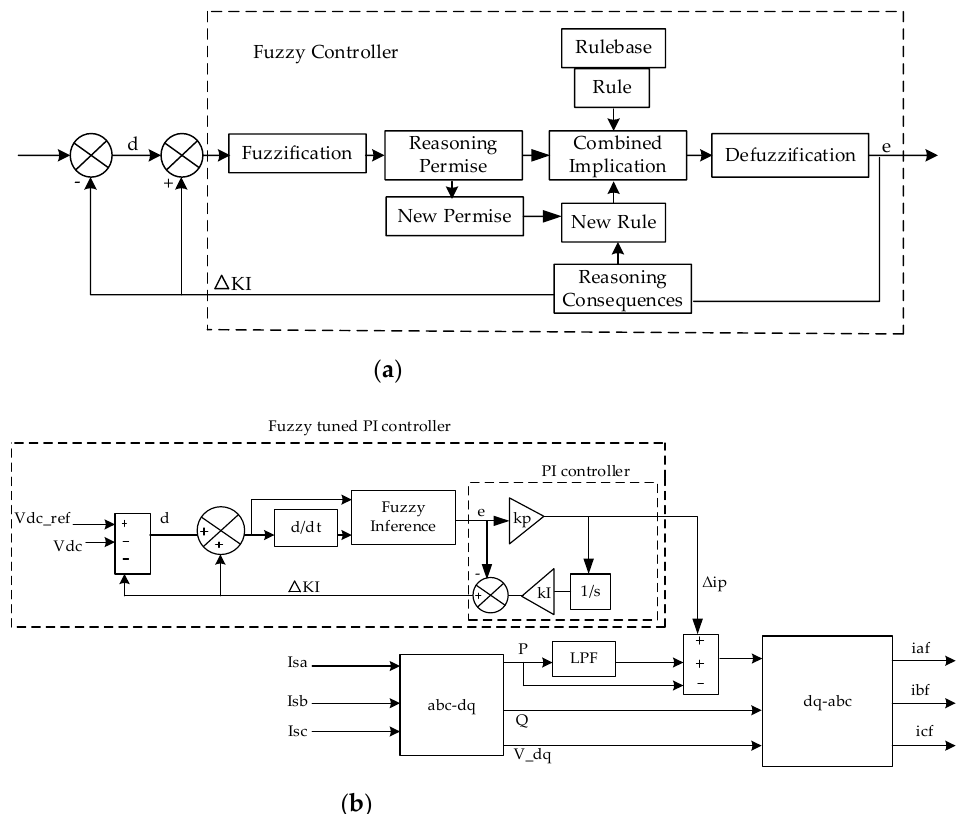
Figure 4. The arrangement of the ( a ) fuzzy control structure and ( b ) fuzzy control model.